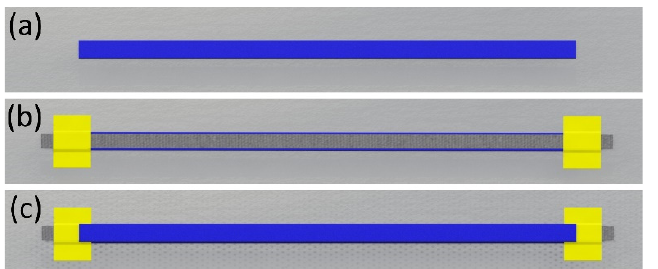
Figure 1. Preparation steps of the samples as modeled in Solidworks: ( a ) 3D printing of the sample’s bottom half-layer, ( b ) placement of the CFC piece with the use of Kapton tape, and ( c ) continuing the 3D printing until the sample was ready.